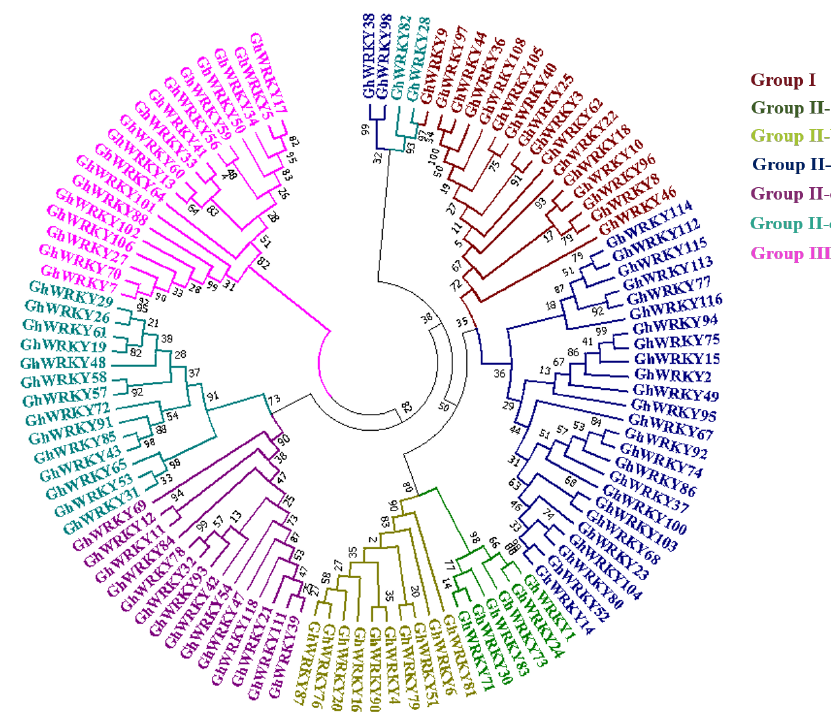
Figure 3. Phylogenetic analysis of WRKY proteins. For phylogenetic analysis of G. hirsutum , the tree is drawn to scale, with branch lengths measured in the number of substitutions per site. The maximum likelihood tree includes WRKY protein sequences of G. hirsutum. Each group of GhWRKYs is represented by a unique color. Table 2. Promotor analysis of GhWRKY25 and GhWRKY33